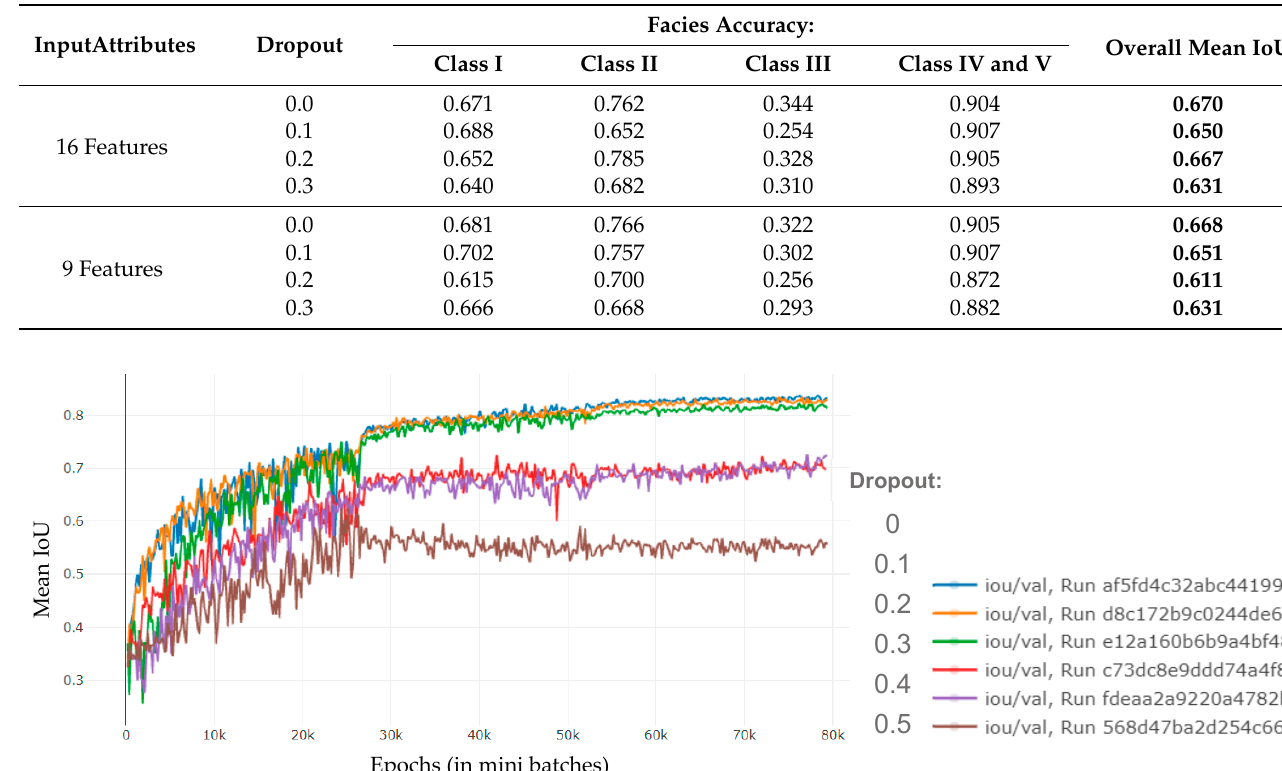
Table 3. Results in the two categories, with dropout variations, in the test dataset. All metrics are in the range of 0 to 1, with larger values being better. The best-performing model for every metric is highlighted in bold.